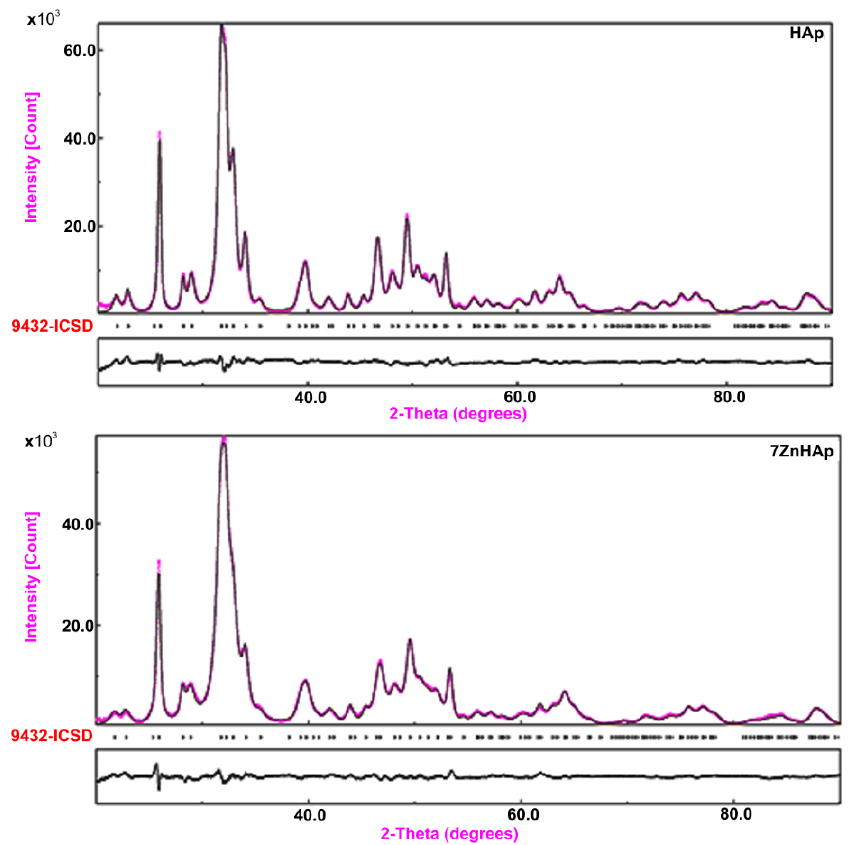
Figure 1. Rietveld processing of HAp and 7ZnHAp samples prepared by sol-gel method. Experimental data was depicted in pink while calculated data was depicted in a black line. Vertical lines represent the positions of diffraction lines of hexagonal hydroxyapatite (ICDD-PDF No. 9-432). The black line at the bottom of the figure represents the profile of the difference between experimental data and those calculated using the Rietveld method.